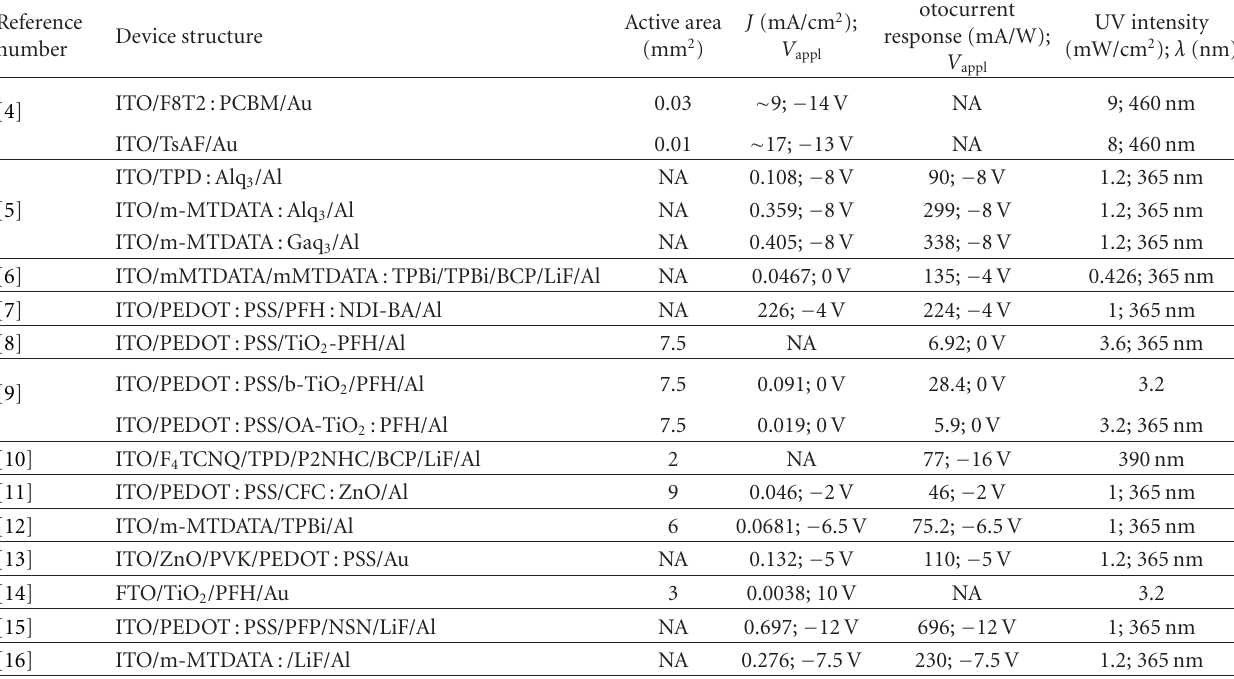
Table 1: Properties of organic semiconductor-based photodetectors already published in the literature.